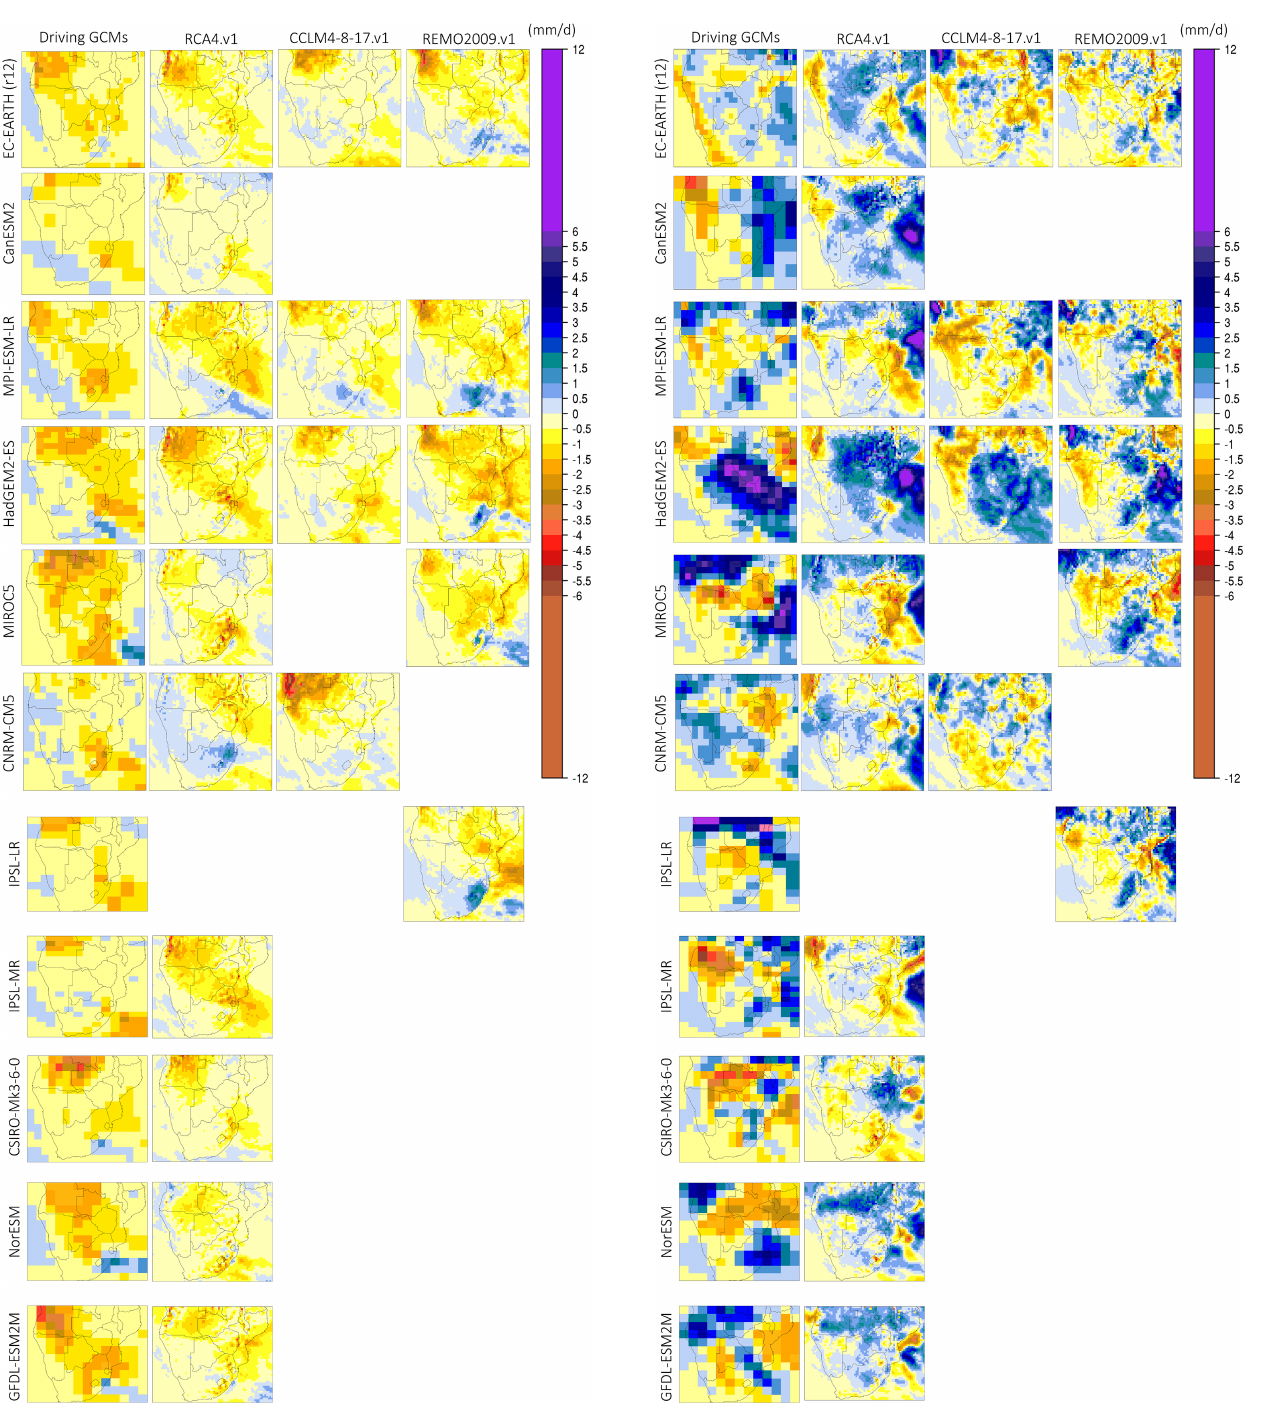
Figure 10. Monthly precipitation change (future–present, in mmd − 1 ) during October for the period 2065–2095 relative to 1985–2005. The first column (from the left) displays the precipi- tation change for the driving GCMs used, and columns 2–4 display the downscaled products according to RCA4.v1, CCLM4-8-17.v1, and REMO2009.v1.